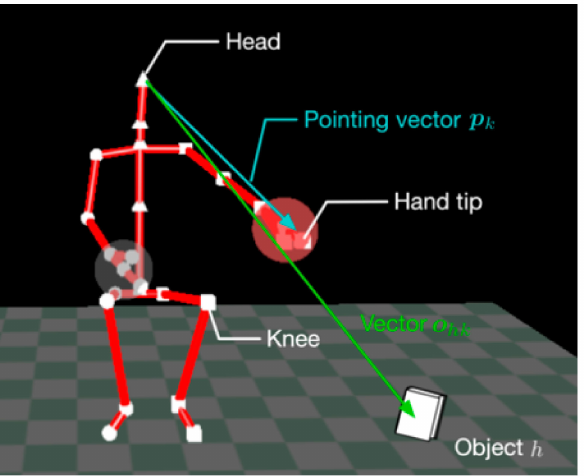
Figure 5. Pointing vector and the vector connecting a human head and an